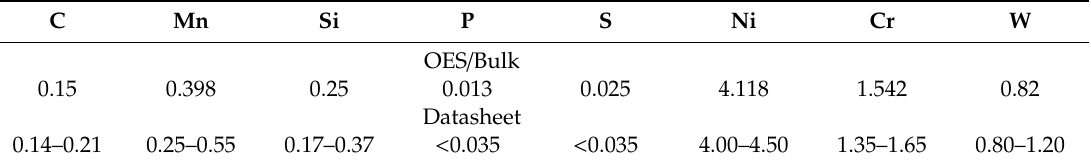
Table 4. Chemical composition of steel equivalent 17Ni4CrMo (i.e., CSN 41 6720) verified by Tasman Q4 Bruker